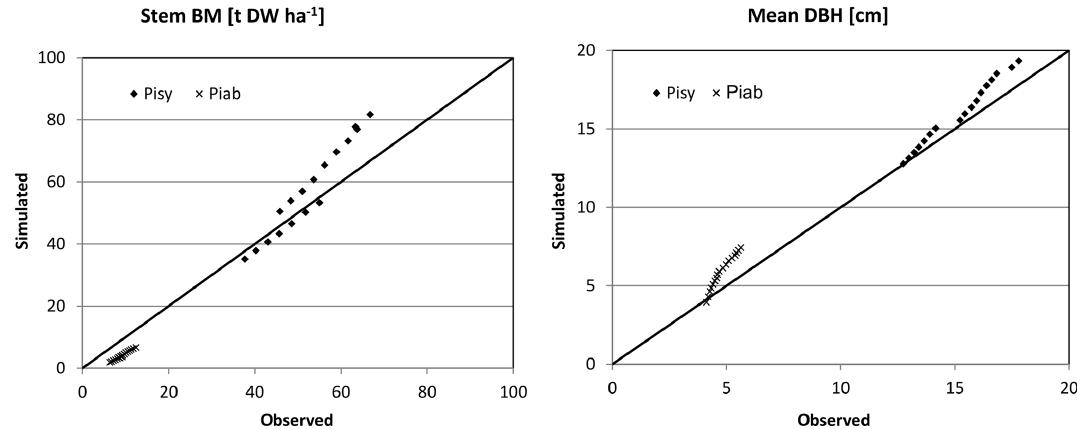
Figure 5. Simulated (sim) vs. observed (obs) DBH and stem biomass (BM) for Hyytiälä (Pisy – pine, Piab – spruce) in the form of scatter plots with a 1 : 1